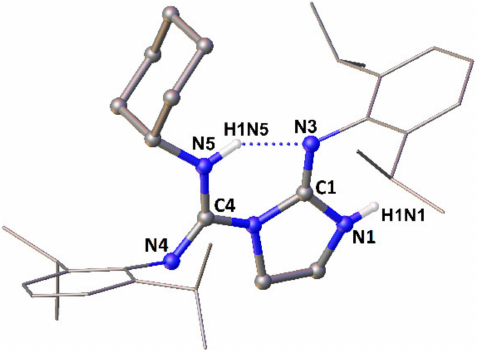
Figure 2. Solid-state structure (hydrogen atoms except the NH are omitted for the sake of clarity) with selected bond lengths (Å) and angles (deg) of 1 : C1–N1 1.364(2), C4–N4 1.278(2), C1–N3 1.280(2), N2–C4–N5 124.45(11), N2–C1–N3